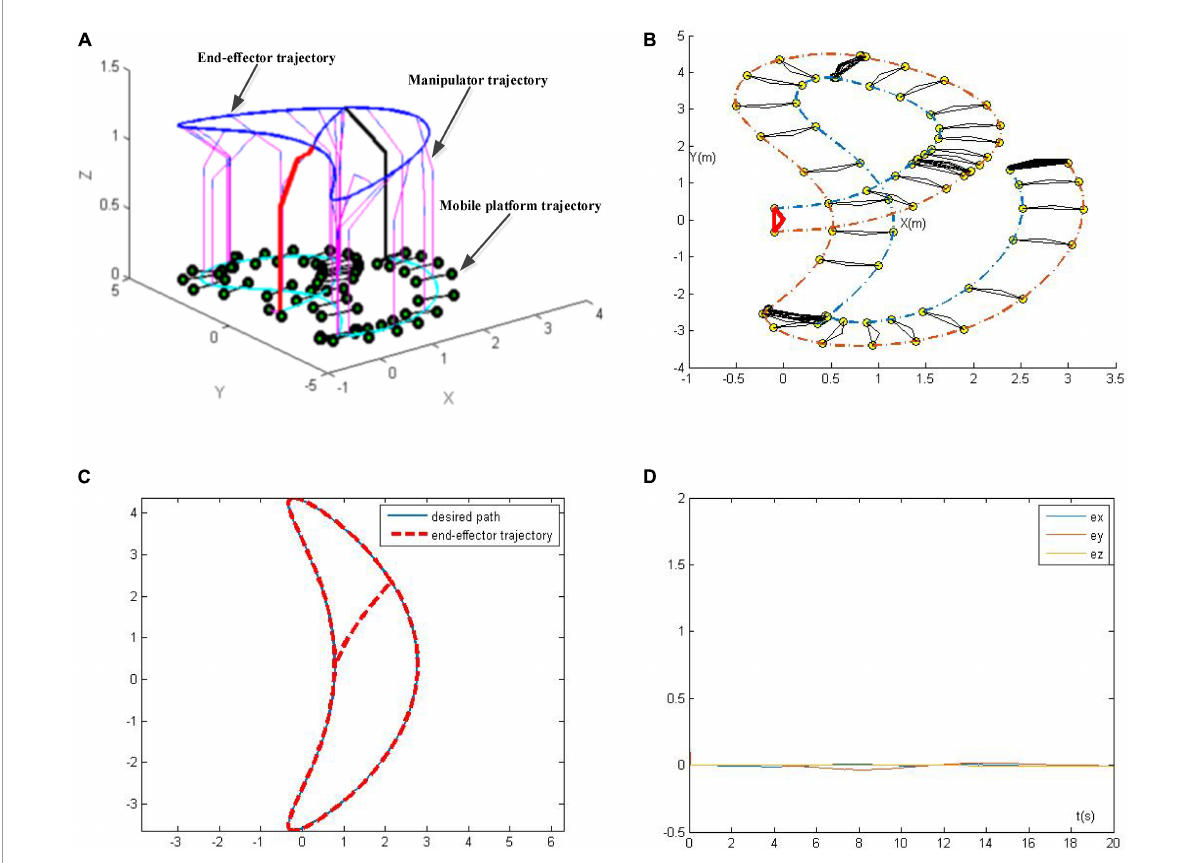
FIGURE11 Trajectory tracking results of the robotic manipulator synthesized by robust zeroing neural network (RZNN) model with n(t) = 0.5. (A) Whole tracking trajectory of the manipulator, (B) mobile platform trajectory, (C) desired path and the end-effector trajectory, and (D) tracking errors.